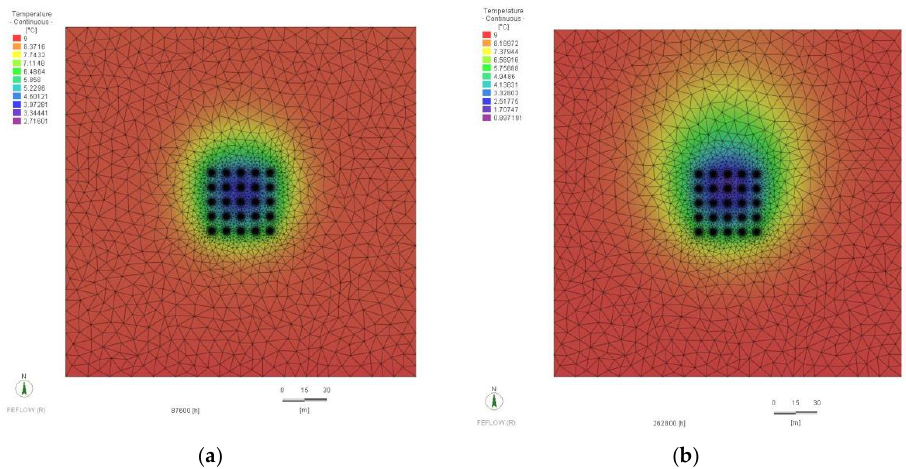
Figure 13. Results of the simulation of ground temperature after 10 years ( a ) and 30 years ( b ) of heat pump operation within the 3rd scenario (layered model). Two-dimensional view of the surface at a depth of 50 m.